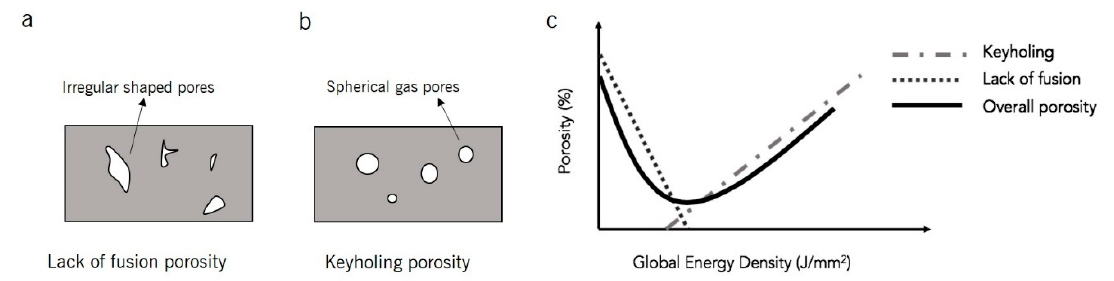
Figure 6. Schematic of: ( a ) Lack of fusion porosity (interlayer porosity), ( b ) keyholing porosity (intralayer porosity), and ( c ) the intersection of interlayer and intralayer porosity with respect to global energy density (GED).